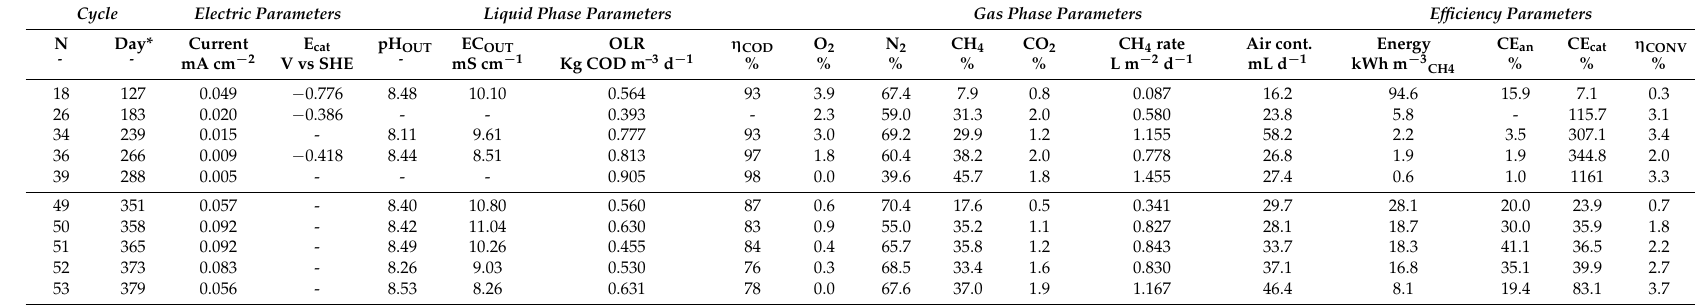
Table A9. Selection of 10 cycles for BES 5, operated at constant 0.7 V voltage with synthetic medium (first five cycles) and real municipal wastewater (last five